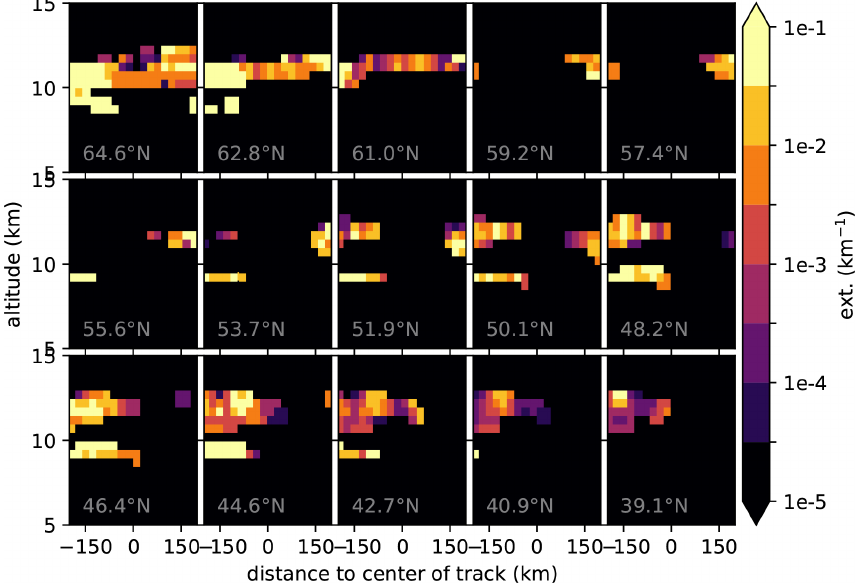
Figure 8. Cross section through CLaMS-ICE extinction data corresponding roughly to the field of view of the IRLS. Only every second image of the IRLS is